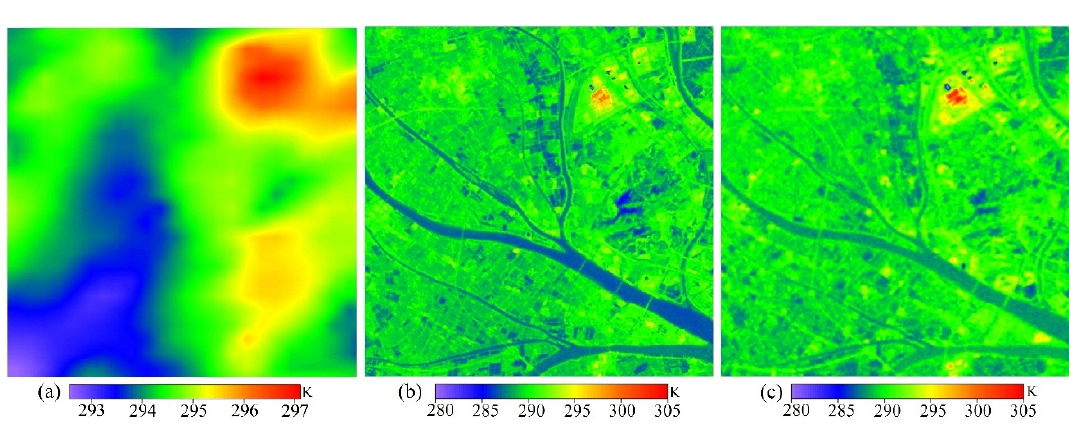
Figure 7. SADFAT result in the testing experiment. (a) MODIS LST images resampled from 1 km to 60 m; (b) SADFAT-derived image at 60 m; (c) original Landsat ETM+ LST image at 60 m spatial on 7 December 2013.